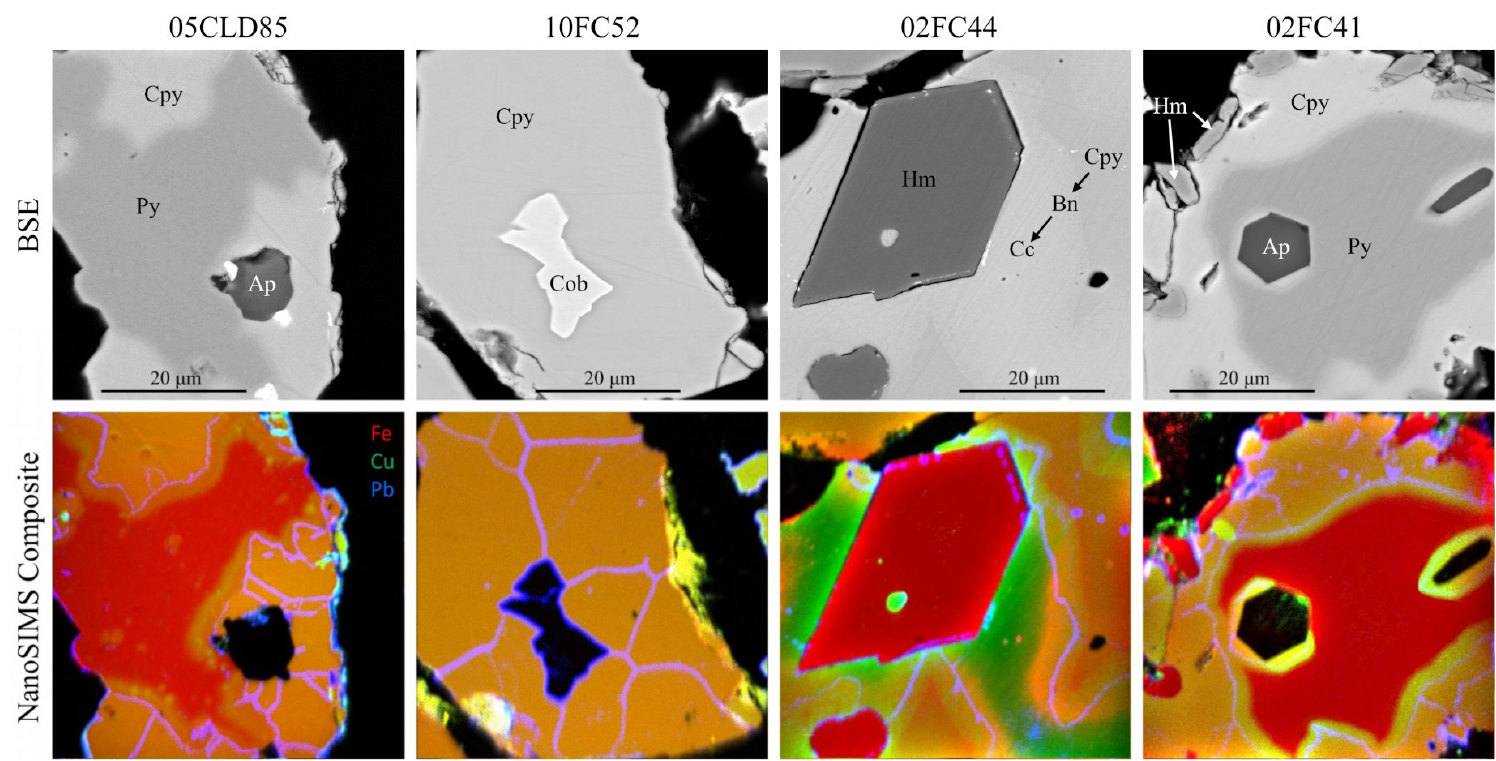
Figure 11. The BSE image (upper row) and nanoSIMS composite images of sulfide assemblages in samples 05CLD85, 10FC52, 02FC44, and 02FC41. Abbreviations: Cpy-chalcopyrite; Py-pyrite; Ap-apatite; Cob-cobaltite; Hm-hematite; Bn-bornite; Cc-chalcocite. The composites represent overlapping nanoSIMS maps of Fe (red), Cu (green), and Pb (blue)—the color scheme is uniform for all four composites. Note that orange is the result of a red and green overlap and magenta is the result of a blue and orange overlap. Lead-206 lines / spots are pervasive throughout chalcopyrite and bornite, but are virtually absent in hematite, chalcocite, and